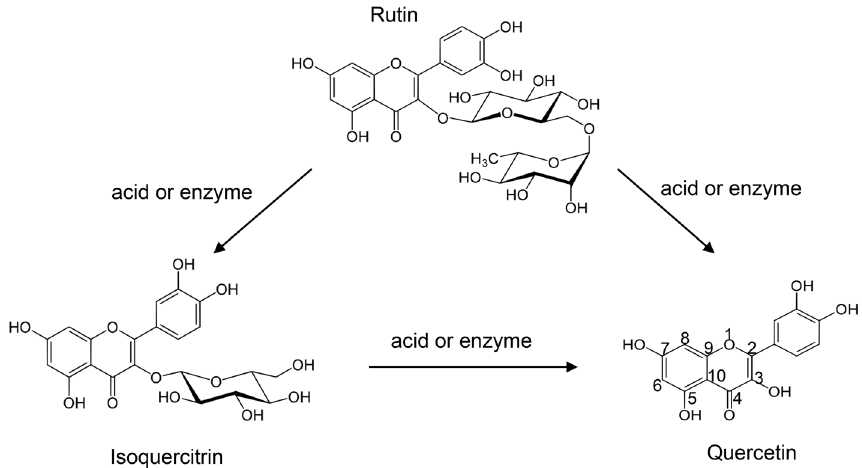
Fig. 2 Conversion of rutin to quercetin or isoquercitrin. Aadapted from Nam et. al. (2012), Isaak et. al. (2013), and Baby et. al.